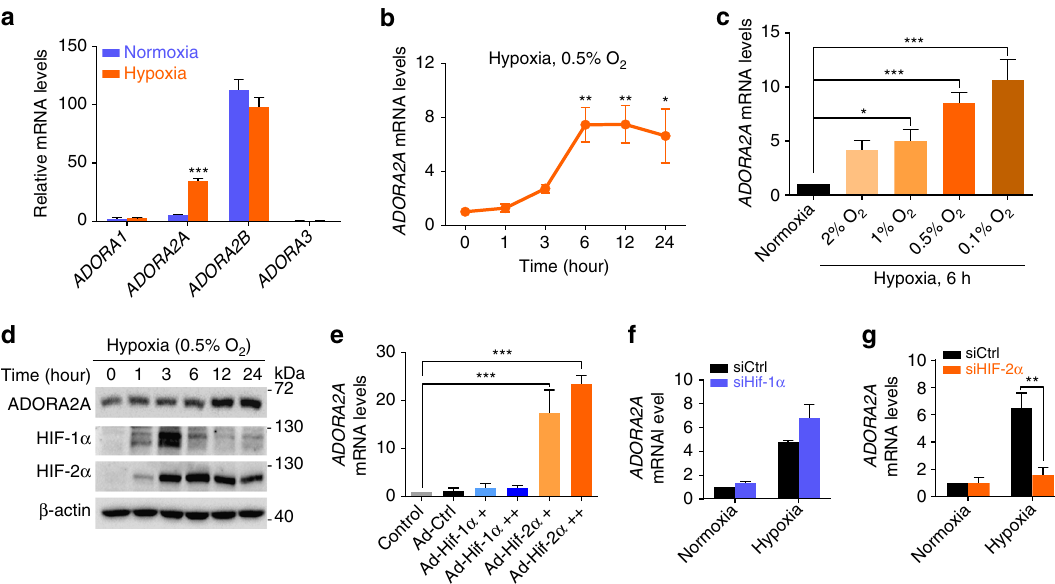
Fig. 3 Hypoxia upregulates ADORA2A expression by activating HIF-2 α in HRMECs. a Real-Time PCR analysis of mRNA expression for adenosine receptors in HRMECs. HRMECs were exposed to normoxia (21% O 2 ) or hypoxia (0.5% O 2 ) for 6 h. n = 4. *** P < 0.001 vs. normoxia. b , c Real-Time PCR analysis of ADORA2A mRNA expression in HRMECs. HRMECs were exposed to normoxia (21% O 2 ) or hypoxia (0.5% O 2 ) for indicated times b or with indicated O 2 concentrations for 6 h c . n = 4. * P < 0.05; ** P < 0.01, *** P < 0.001 vs. normoxia. d Western blot analysis of ADORA2A protein expression in HRMECs exposed to hypoxia (0.5% O 2 ) for indicated times. n = 4. HIF-1 α and HIF-2 α were used as positive controls for hypoxia, and β -actin was used as loading control. e Real-Time PCR analysis of ADORA2A mRNA expression in HRMECs. HRMECs were infected with 10 ( + ) or 30 ( + + ) pfu per cell of either Ad-mutHIF-1 α , Ad-mutHIF-2 α , or Ad-Ctrl. n = 3. * P < 0.001. f , g Real-Time PCR analysis of ADORA2A mRNA expression in HRMECs. HRMECs were transfected with siHIF-1 α f , siHIF-2 α g , or siCtrl. Forty-eight hours later, cells were exposed to hypoxia (0.5% O 2 ) or air (21% O 2 ) for an additional 12 h. n = 4. ** P < 0.01. Data are represented as means ± s.e.m. Statistical signi fi cance was determined by unpaired Student ’ s t